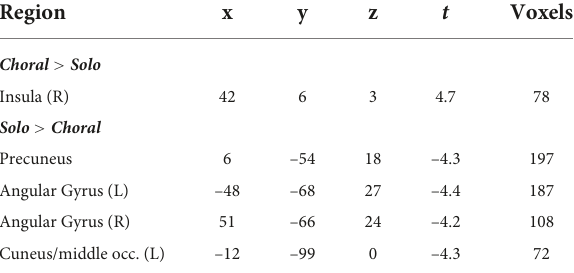
TABLE 2 Regions showing significant functional connectivity in AWS using an a priori determined left superior temporal gyrus (LSTG) seed (Toyomura et al.,